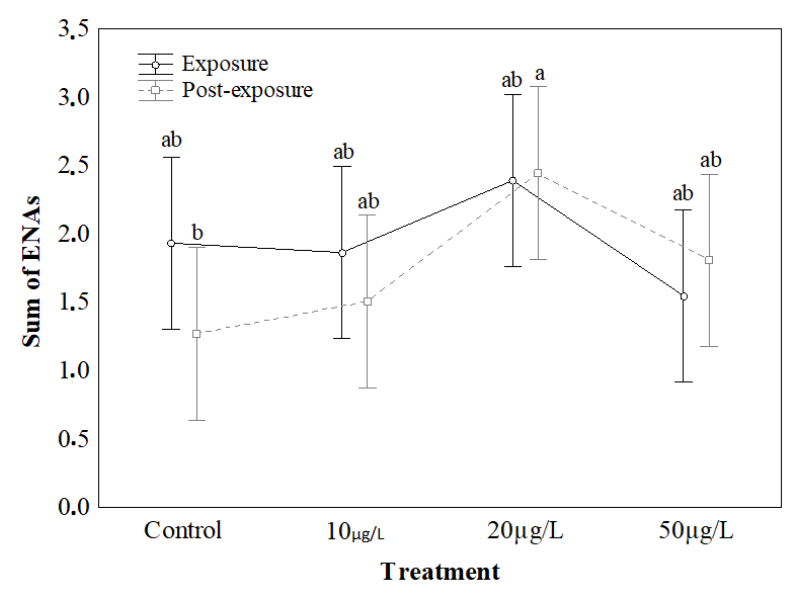
Figure 2. Sum of erythrocyte nuclear abnormalities (ENAs) in Leptodactylus latrans after 96 hours of exposure to Elatus® (Exposure) and 96 hours after the end of exposure (Post-exposure). Different letters indicate a significant difference, while values marked with the same letters are statistically similar according to the factorial ANOVA test. The data are presented as mean (circles) and standard deviation (vertical